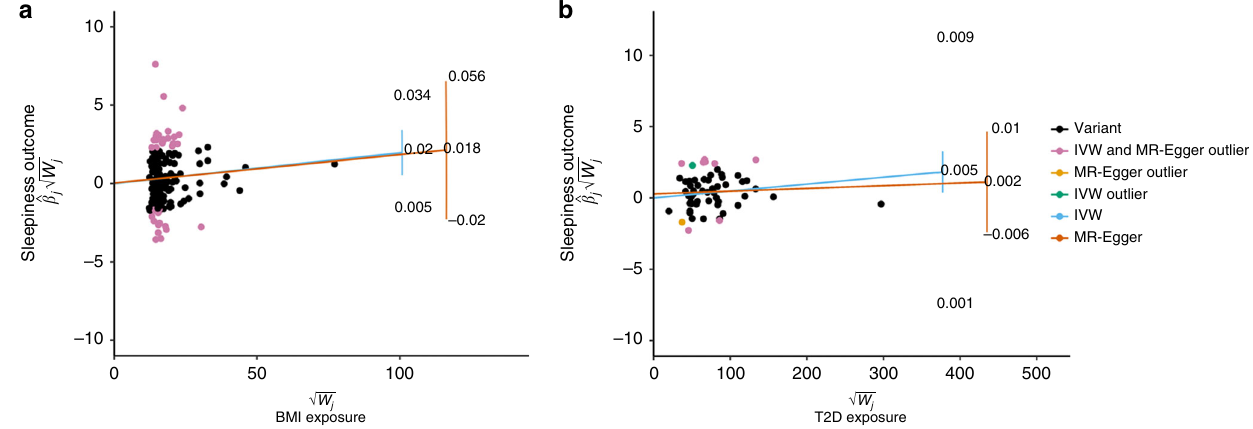
Fig. 4 Radial plots of two-sample Mendelian randomization (MR) analysis of daytime sleepiness. a MR between BMI and daytime sleepiness outcome using IVW and MR-Egger tests. b MR between Type 2 diabetes and daytime sleepiness outcome using IVW and MR-Egger tests. The x -axis is the inverse standard error (square root weights in the IVW analysis) for each SNP. The y -axis scale represents the ratio estimate for the causal effect of an exposure on outcome for each SNP ( ^ β j ) multiplied by the same square